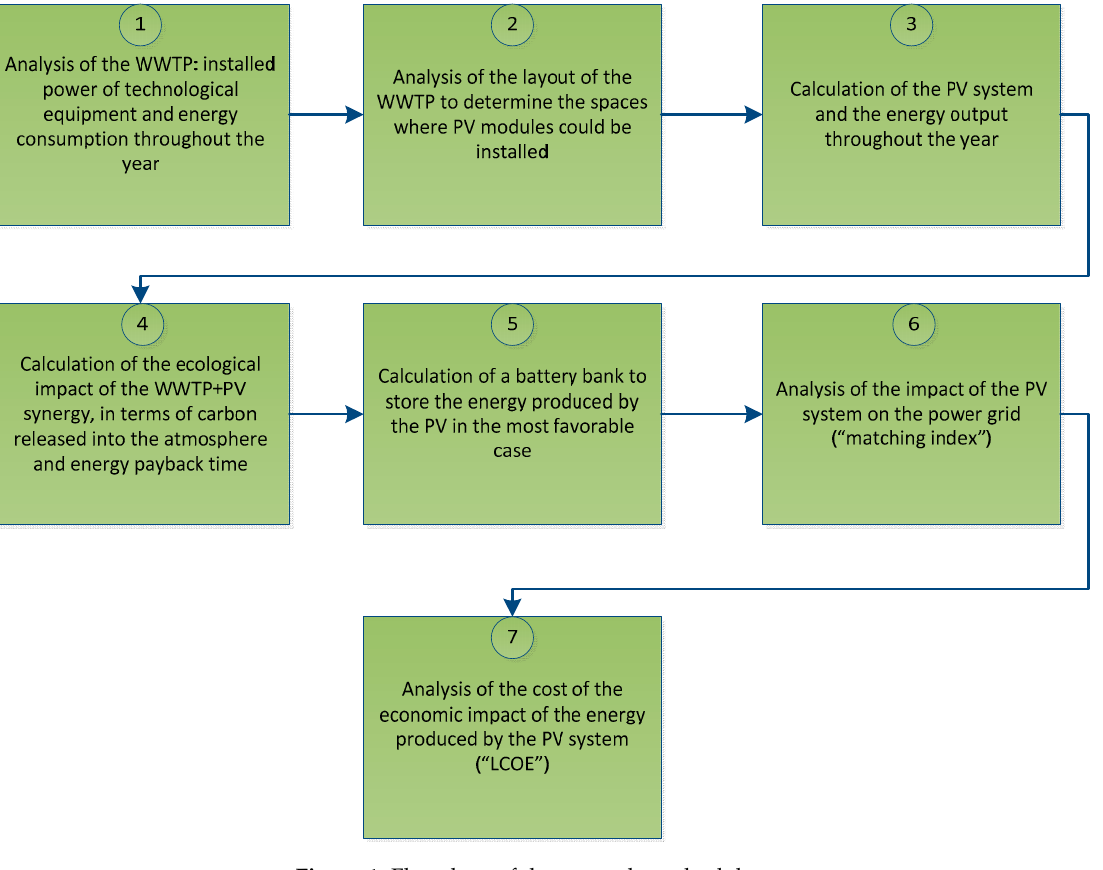
Figure 1. Flowchart of the research methodology.